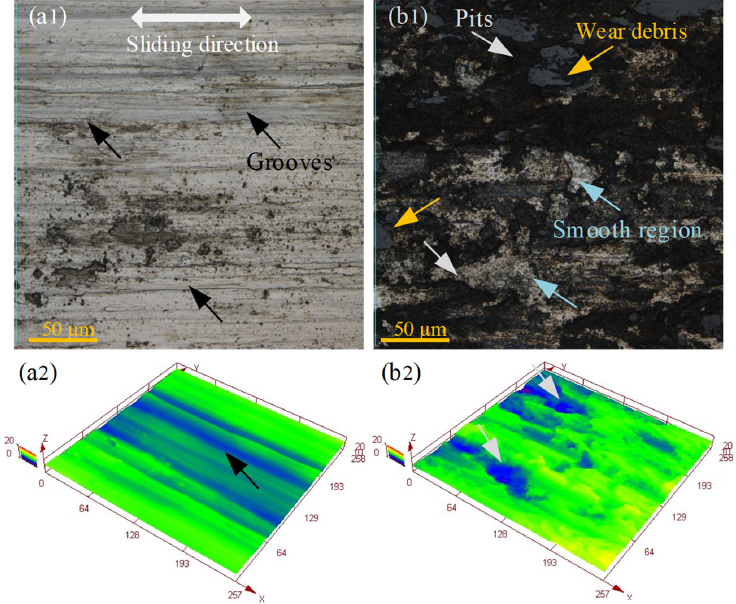
Figure 8. Magnified 2D and 3D worn morphology: ( a1 , a2 ) 316L coating and ( b1 , b2 ) composite coating.